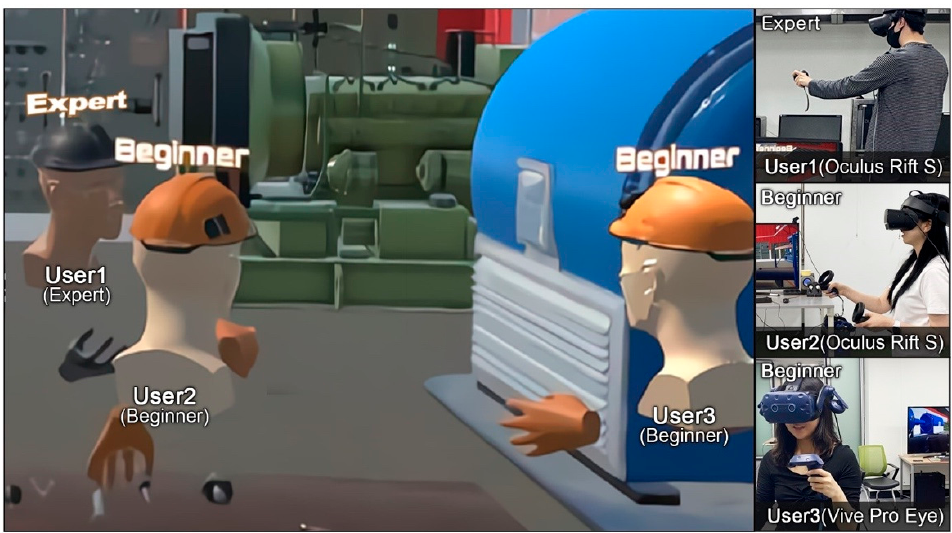
Figure 2. Simulation designed for demo testing.